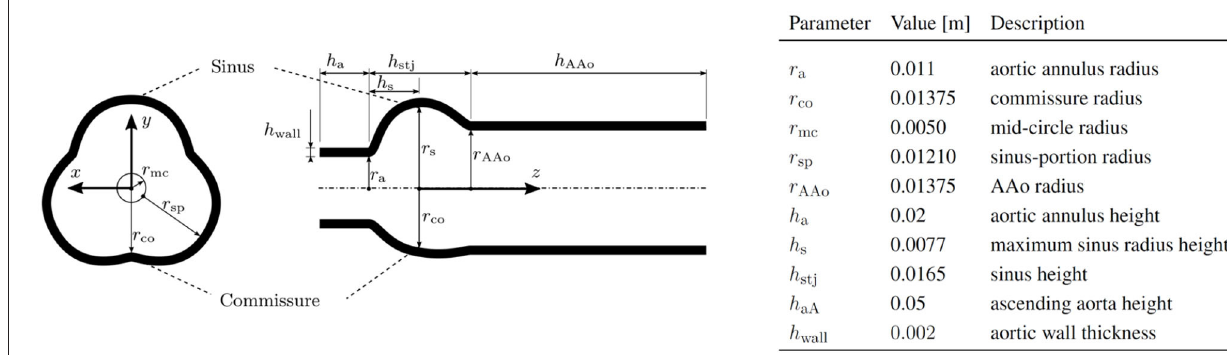
FIGURE 3 | Geometry of the parameterized